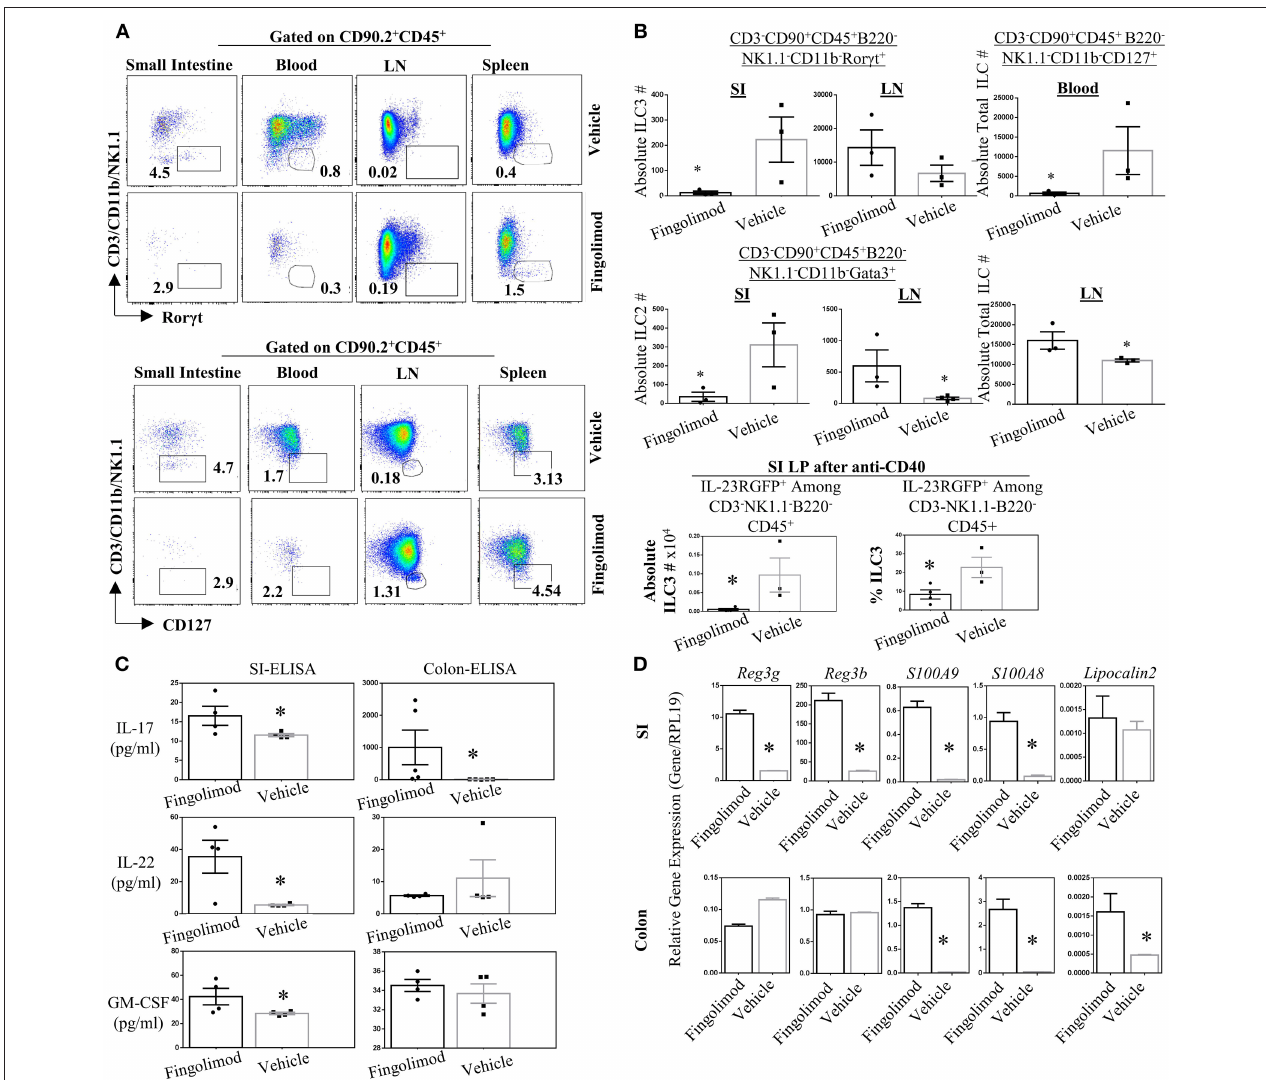
FIGURE 3 | Fingolimod causes ILC-penia, augments lymph node ILC numbers, and decreases small intestine lamina propria ILC3 numbers in mice but does not reduce antimicrobial peptide production. (A) A representative flow plot of the percentages of total ILCs in the small intestine lamina propria blood, inguinal lymph node (LN) and spleen of mice gavage-fed with fingolimod or vehicle for 30 days. The plots show live cells gated on CD90.2 + CD45 + B220- which then plotted as CD3/NK1.1/CD11b vs. Ror γ t (top panel) or Gata3 (bottom panel). (B) Absolute number of Ror γ t + ILC3s (top panel), of Gata3 + ILC2s (middle panel) in the steady state mice after fingolimod of vehicle-gavage feeding for 30 days. Top panel, right, shows total ILCs (CD90.2-CD45 + CD3-B220-CD11b-NK1.1-CD127 + ) in the blood of steady state mice following 30 days of fingolimod or vehicle treatment. The bottom most panel shows absolute number or percentages of IL-23RGFP + ILC3s in the small intestine lamina propria 2-days after anti-CD40 injection following 30 days fingolimod or vehicle treatment. Three-to-four mice per group were used. Experiment was repeated 3 times. (C) 1cm piece of ileum from fingolimod or vehicle-injected mice (for 30 days) were cultured 48h and the supernatants were assessed with ELISA for the production of indicated ILC3-associated cytokines. Four to five of mice per group. (D) 1cm piece of ileum or colon from fingolimod or vehicle-injected mice for 30 days was examined for gene expression of indicated antimicrobial peptides via real-time qPCR. *Indicates p <